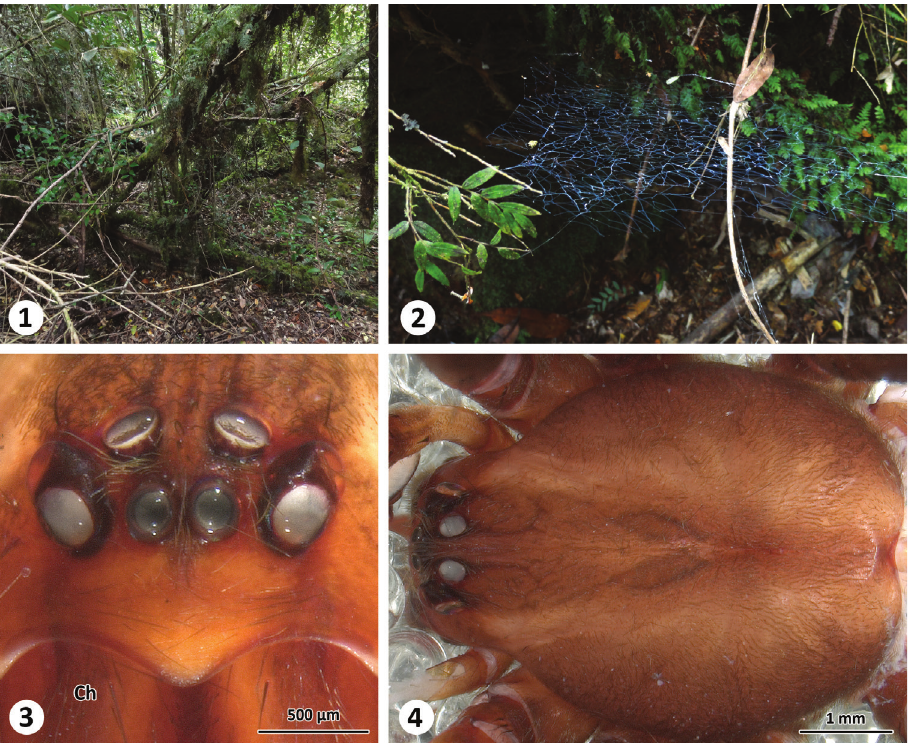
Figure 1–4. Habitat ( 1 ), web ( 2 ) and somatic characters (frontal ( 3 ) and dorsal ( 4 ) view of prosoma) of Thaida chepu